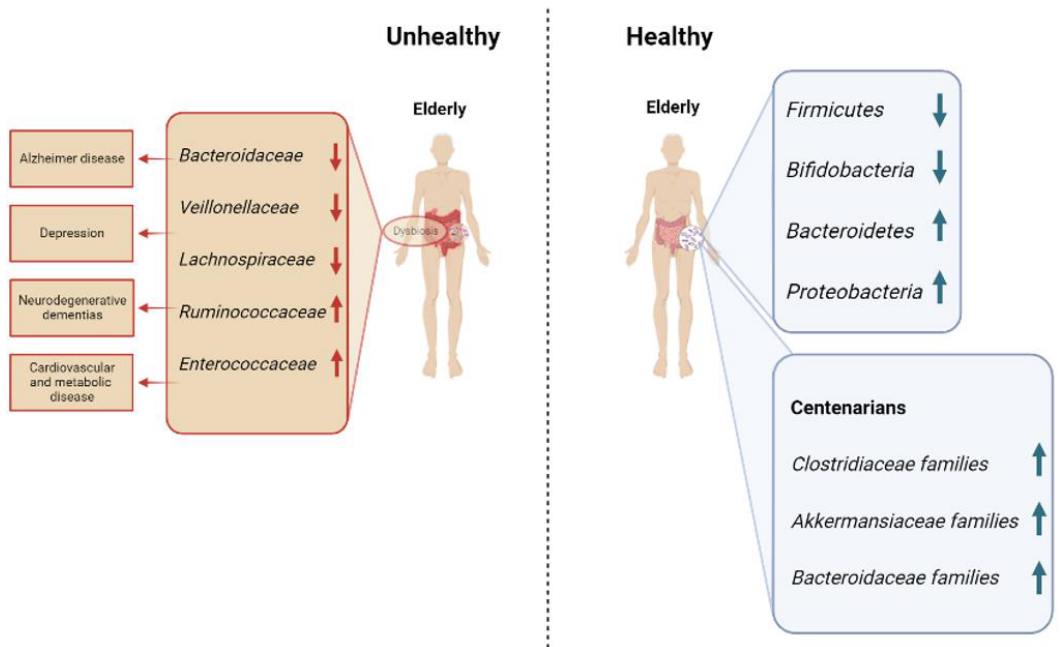
Figure 1. Microbial communities commonly found in unhealthy and healthy elderly, with a focus on centenarians.